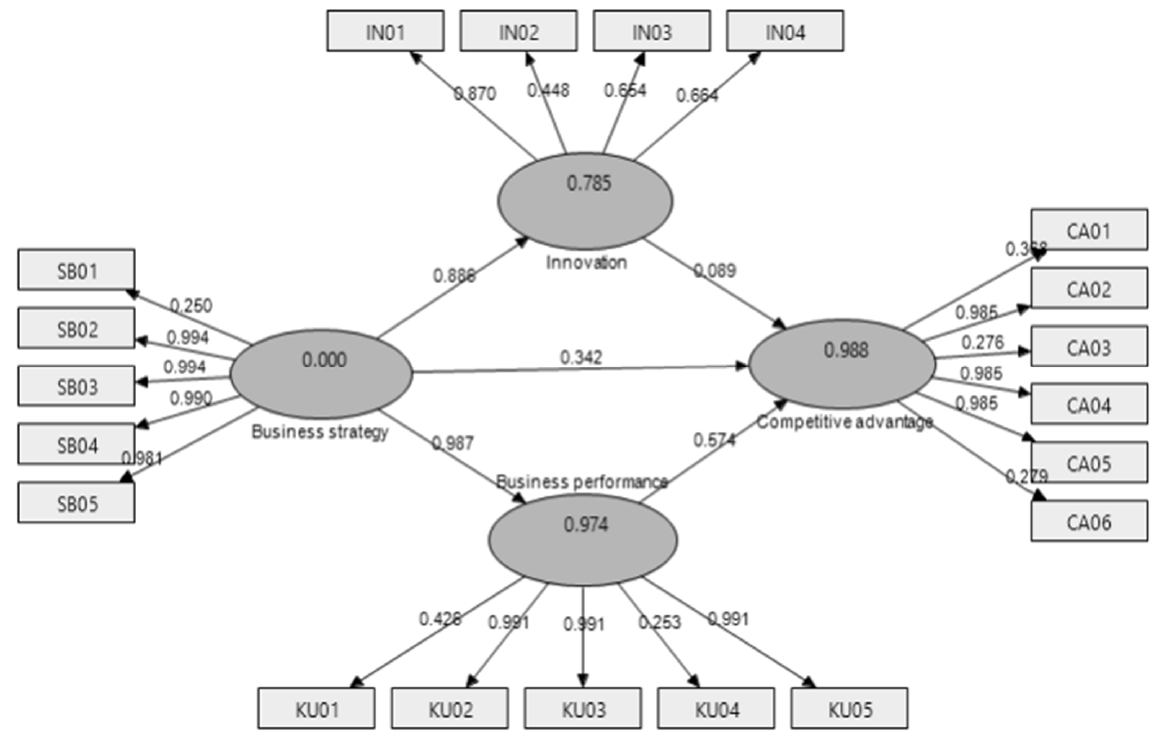
Figure 3. Test results of outer and inner models. Table 5. Testing the research hypotheses.